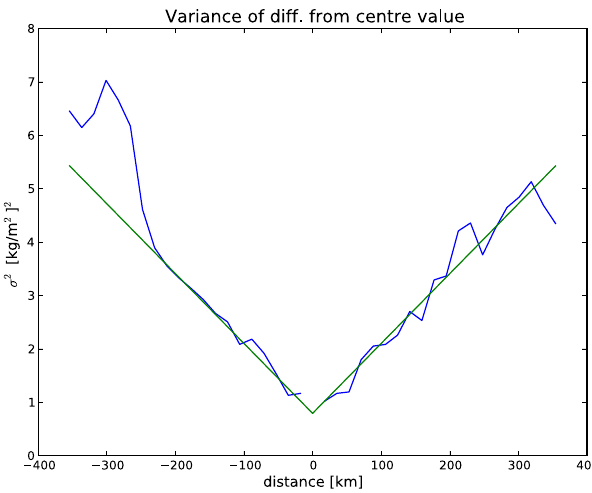
Fig. 5. Variance of paired AMSU-B IWV data as a function of dis- tance along the satellite track for the year 2008 and the satellite N17 (blue) and linear fit (green). Kiruna is at distance 0. The green fit line has the parameters σ 2 = 0 . 0131 | d |+ 0 .